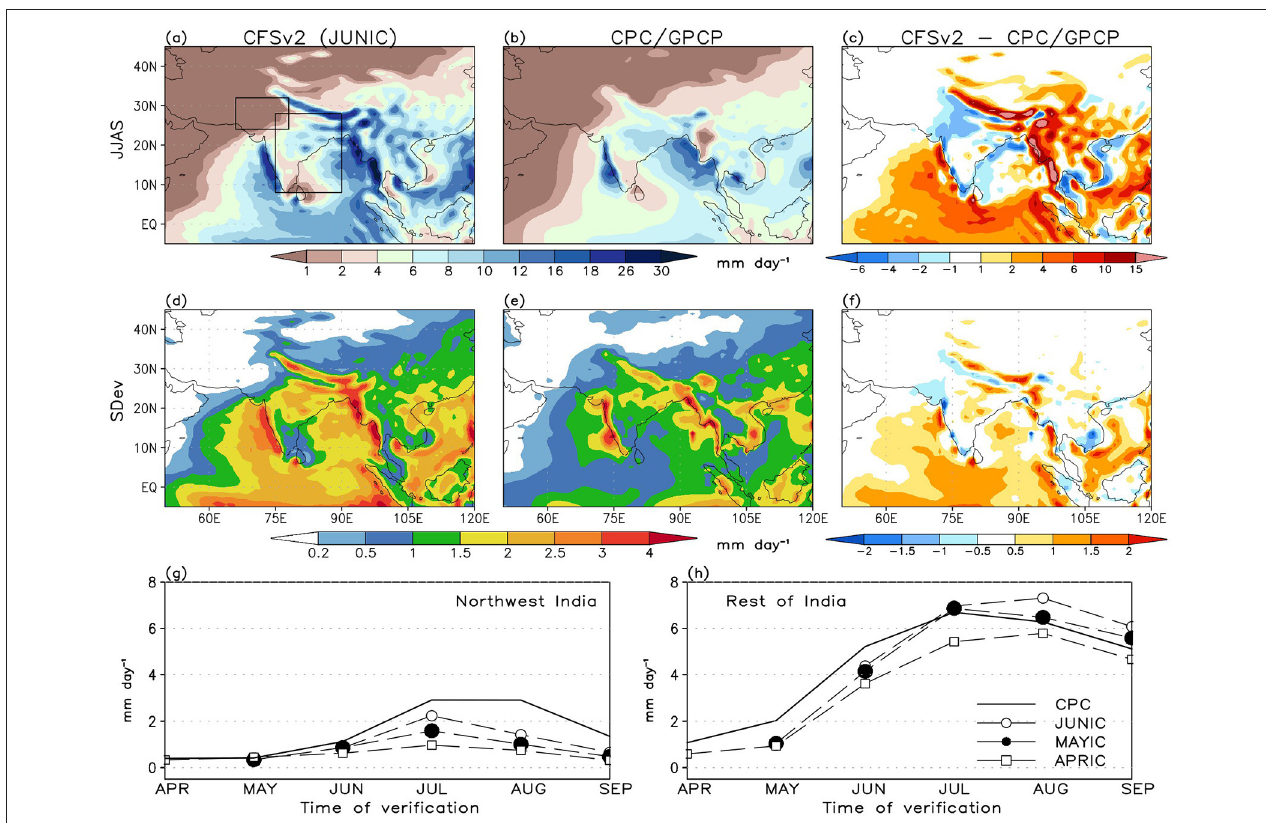
FIGURE 1 | Mean (1982–2009) seasonal (JJAS) precipitation from (a) CFSv2 JUNIC hindcasts and (d) its interannual standard deviation (SDev). (b,e) , respectively show the same for CPC/GPCP2 combined observations. Rightmost column shows differences in (c) seasonal mean and (f) SDev. Units are mm day − 1 . Bottom row shows monthly precipitation over the (g) northwest and (h) rest of India domains as depicted by small and big boxes in the first panel; for JUNIC, MAYIC, and APRIC hindcasts and